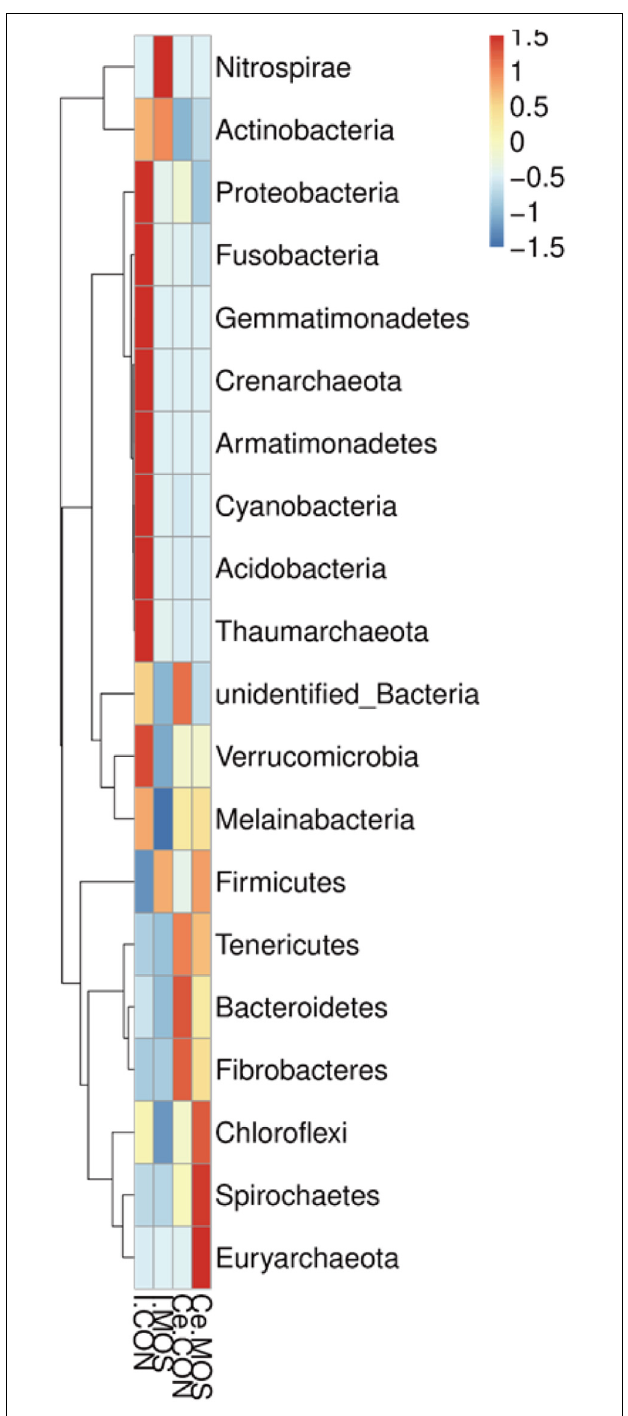
FIGURE 9 | Heatmap distribution of OTUs at genus level. OTUs were arranged in rows and are clustered on the vertical axis. Samples are arranged vertically and are on the horizontal axis. Different colors indicate the relative abundance of taxons. I.MOS means ileal digesta samples from pigs fed with a basal diet supplemented with 3 g/kg MOS; Ce.CON means cecal digesta samples from pigs fed with the basal diet; Ce.MOS means cecal digesta samples from pigs fed with a basal diet supplemented with 3 g/kg MOS. For 16S rRNA analysis, two digesta samples in each group were pooled ( n =